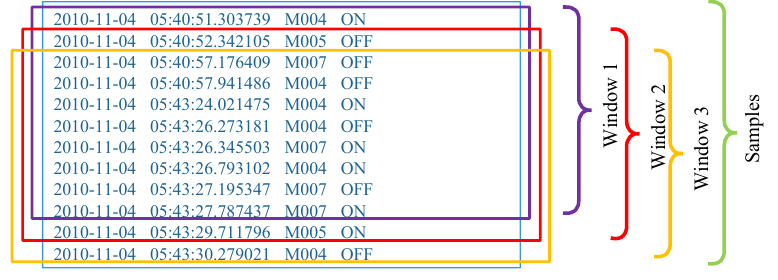
Figure 4. Sliding-window